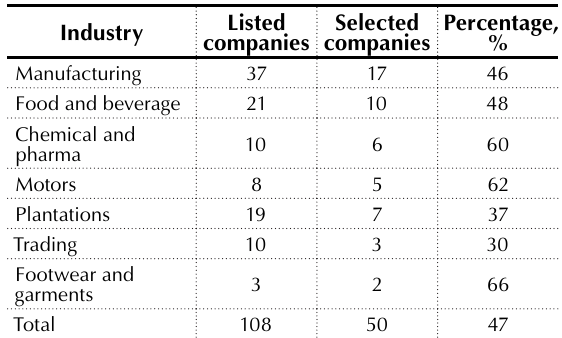
Table 1. Composition of